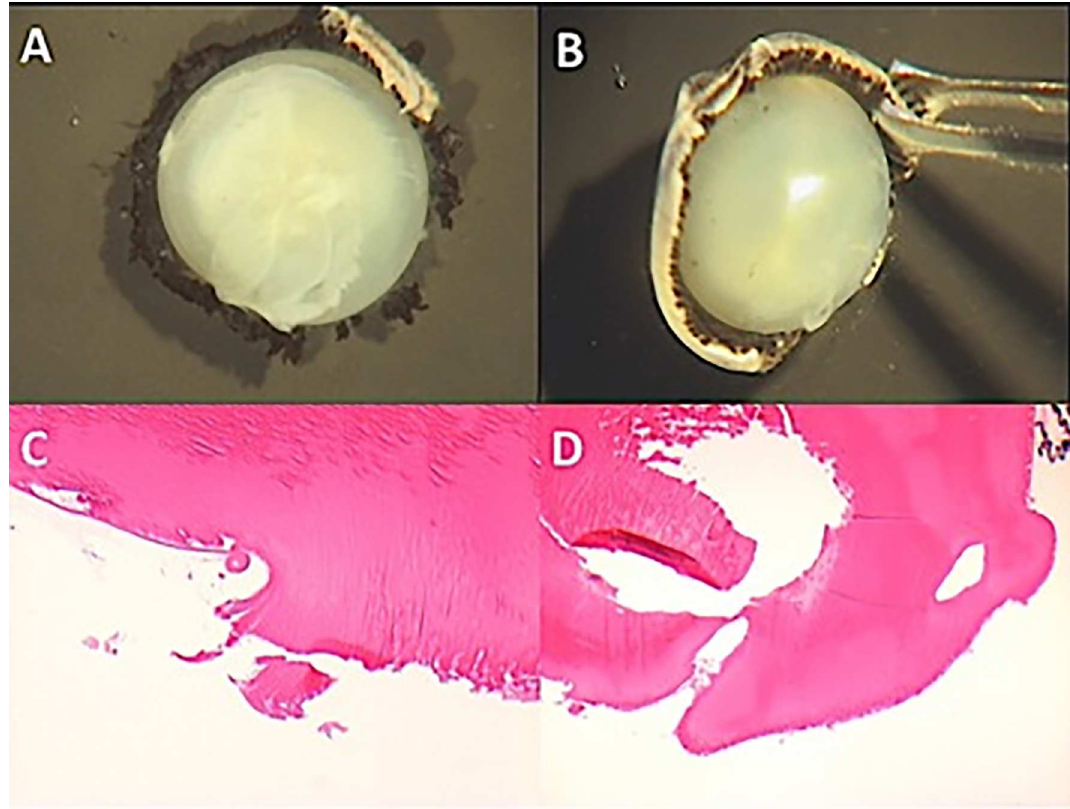
Fig 5. Macroscopic figures showing the effectsof touching a guillotine. (A) or hypersonic (B) vitrector to the posterior capsuleof a cadavericporcine crystallinelens. Microscopicanalysisshowingdisruptionof the posterior capsule of the lenses is extensive with the guillotinevitrector (C) and focal with the hypersonicvitrector (D). Artifactual loss of tissue is also seen in